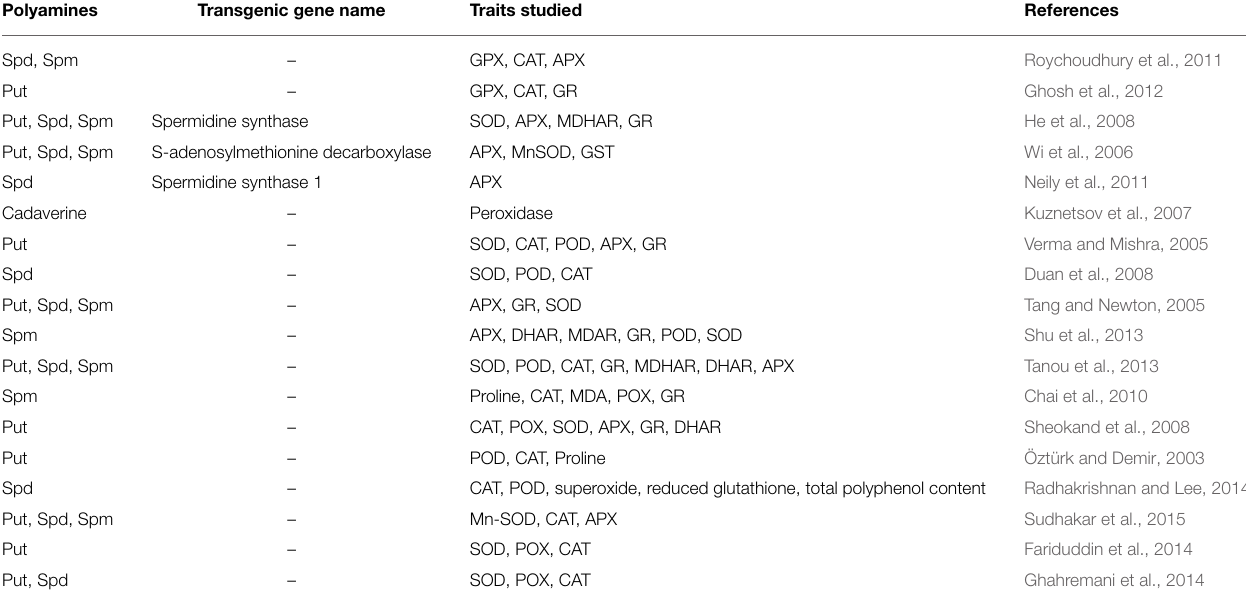
TABLE 1 | Effect of polyamines in the regulation of various enzymatic and non-enzymatic antioxidant components in salt stressed plants.